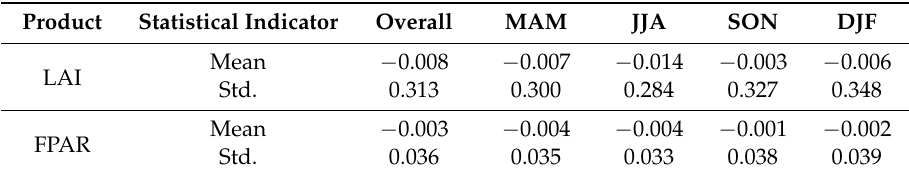
Table 1. The mean and standard deviation (std.) of LAI/FPAR difference between VIIRS and MODIS products (VIIRS-MODIS) at the seasonal scale during 2012–2016.